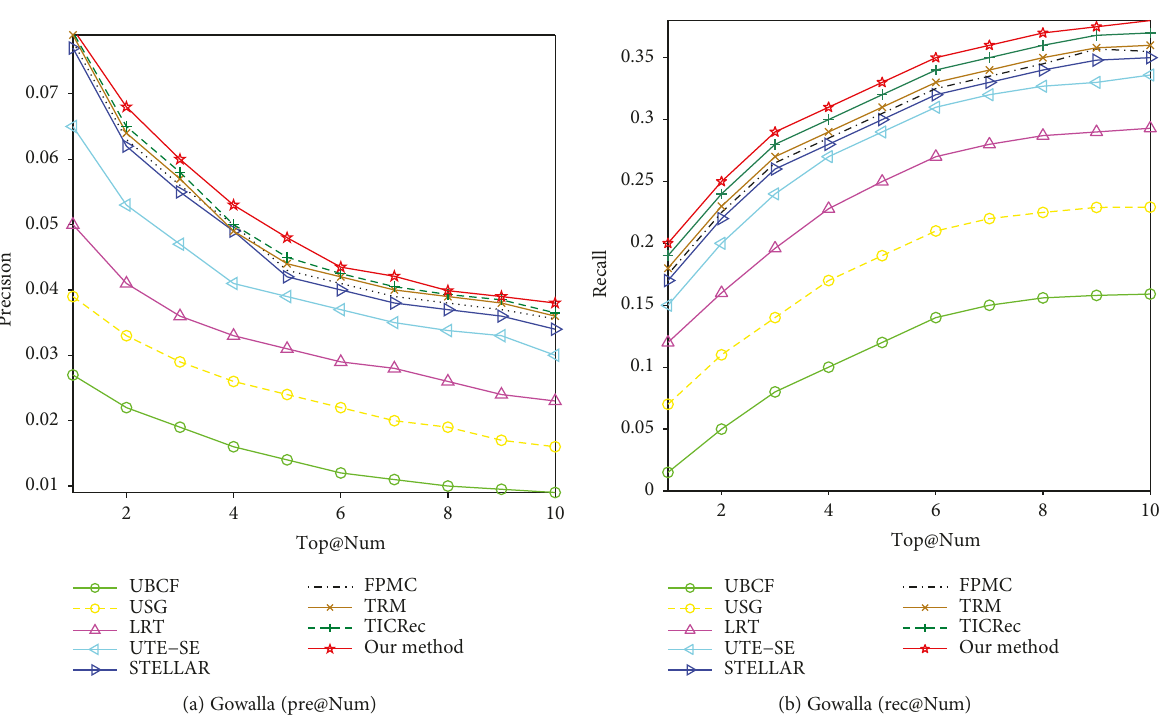
Figure 4: Performance comparison on the Gowalla